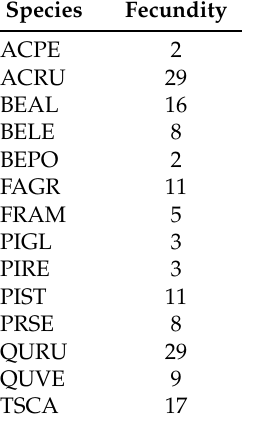
Table A6. Species fecundity parameters.